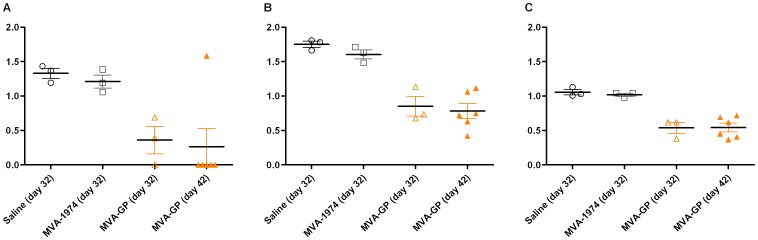
Normalised viral load analysis of CCHFv RNA by RT-PCR.A129 mice (n = 9) were challenged with double the minimum lethal dose of CCHFv, 14 days after booster vaccination with MVA-GP, MVA 1974, or saline. Four days post-challenge (day 32), 3 randomly selected animals from each group were killed humanely and analysed by RT-PCR for CCHFv gene expression, normalised to mouse HPRT gene expression. Fourteen days post-challenge (day 42), all surviving animals were killed humanely and also analysed. Each point represents the mean value of triplicate measurements in an individual animal. Lines show mean ± SEM. In all tissues tested, viral load was significantly lower in MVA-GP vaccinated mice than in control groups. Within the MVA-GP group, there was no significant difference in viral load between 4 days and 14 days post-challenge. (A) Blood. (B) Spleen. (C) Liver.